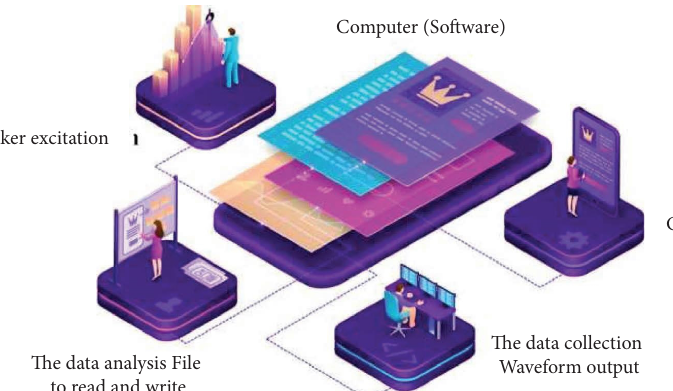
Figure 1: System composition and architecture.